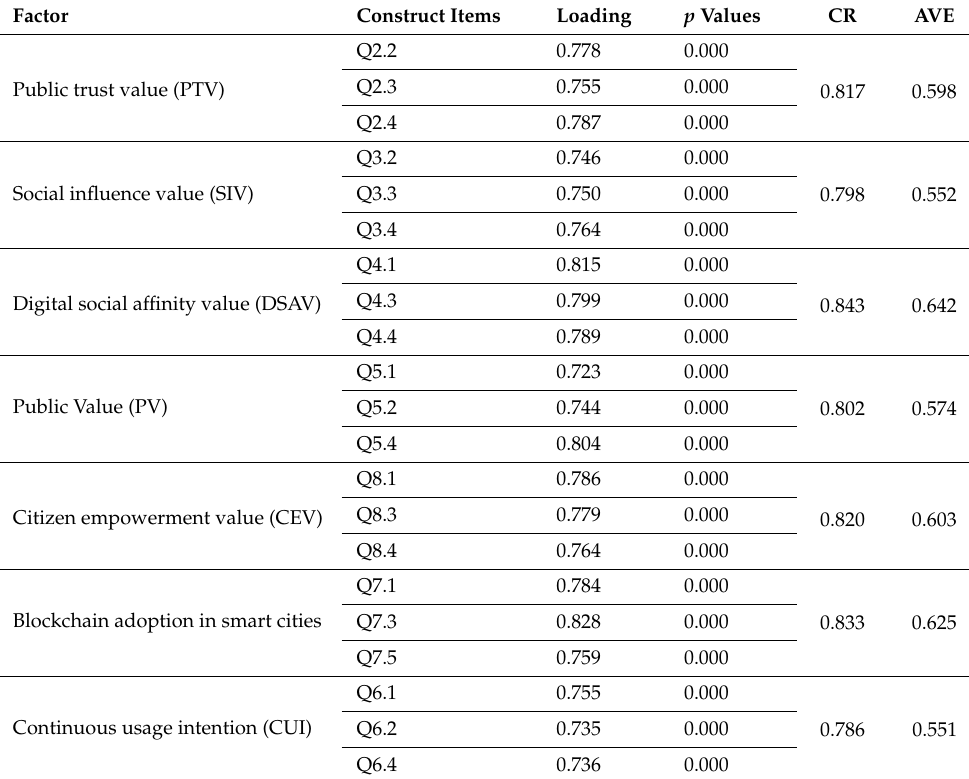
Table 3. Reliability and Convergent Validity of Reflective